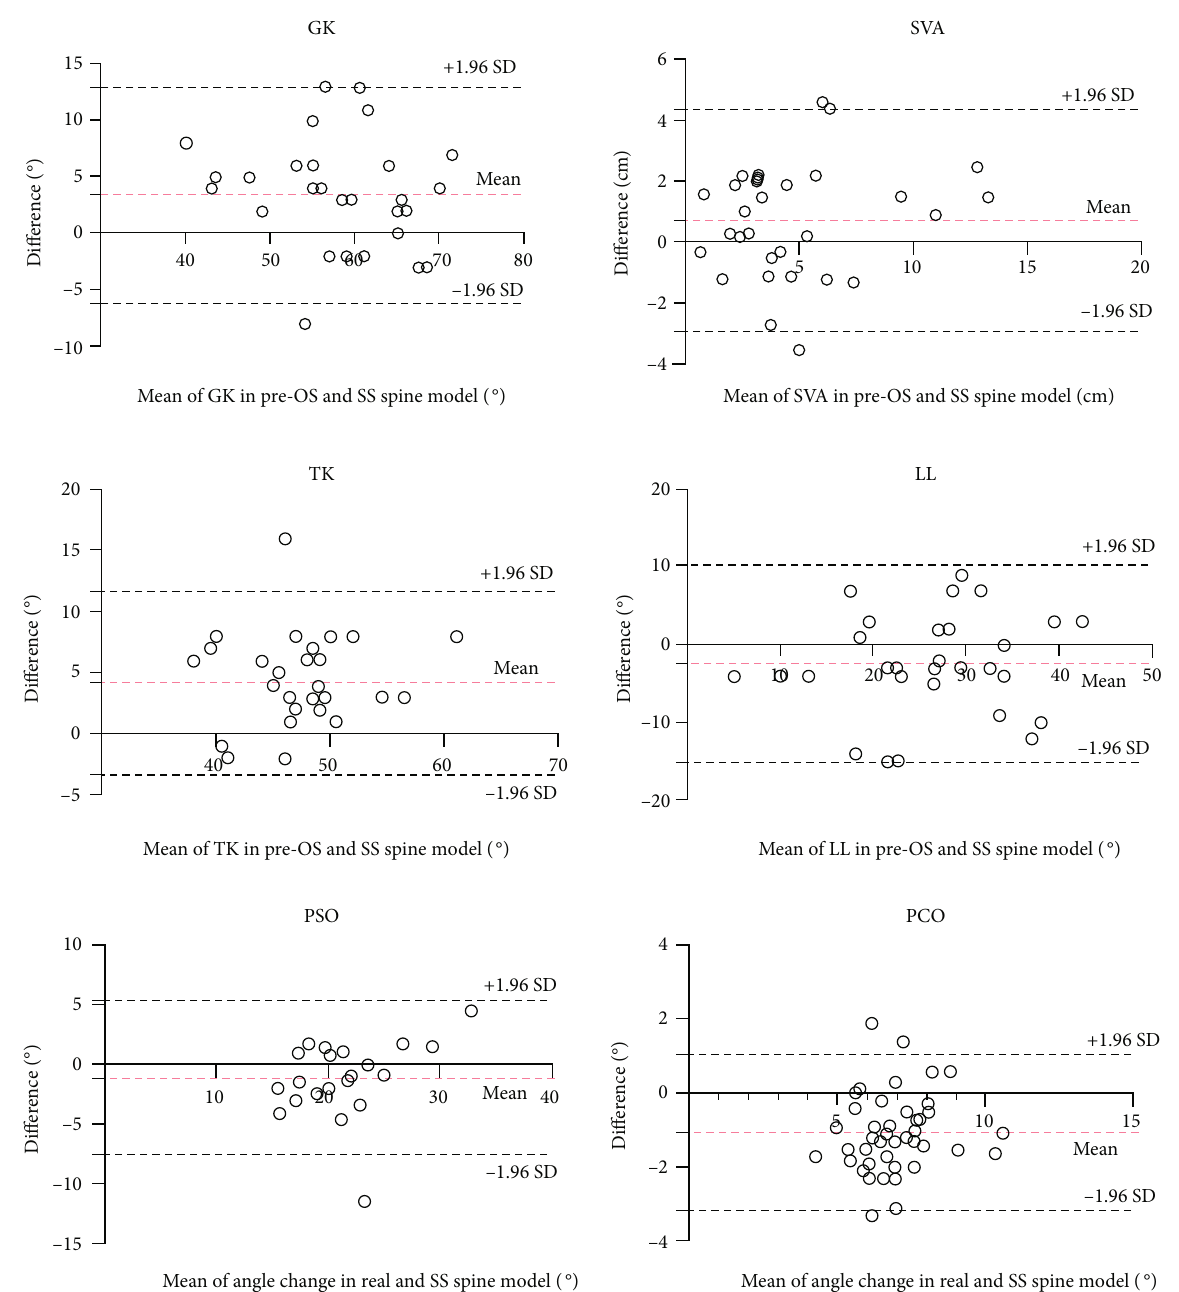
Figure 6: Bland-Altman analysis of radiological parameters. Red dashed lines indicated the mean di ff erence with the corresponding 95% CI, and black dashed lines indicated the limits of agreement with the corresponding 95% CI. Table 3: Results of ICCs and Bland-Altman analysis for the angle changes in real and simulated osteotomies. Type of